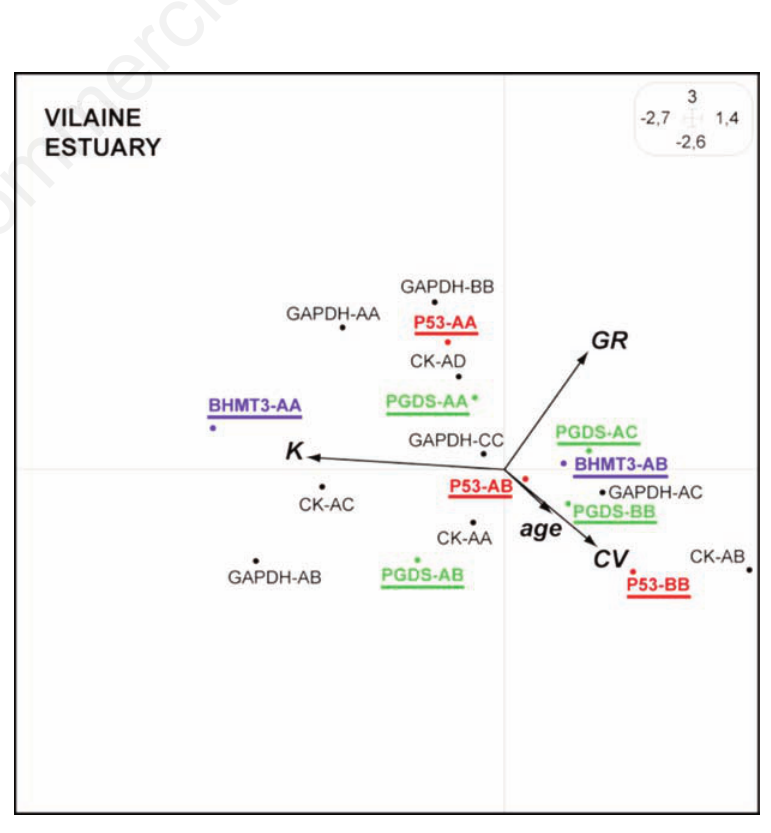
Figure 3. Synthetic Hill and Smith analysis for European flounders from the Vilaine estu- ary. The main 2 first axes explain 52% of the total variance. See Figure 1 caption for